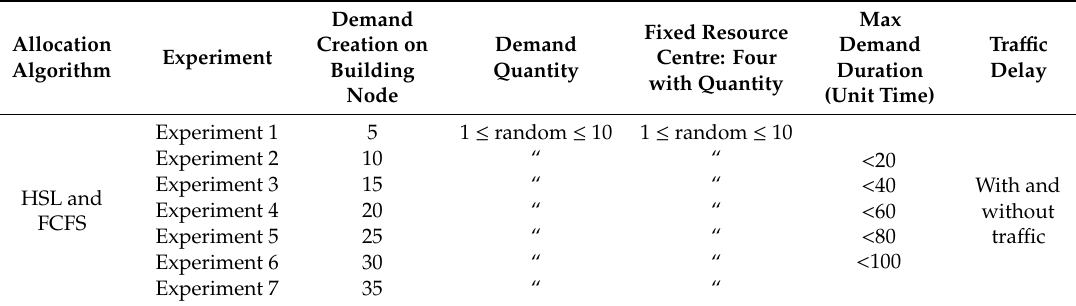
Figure 6. RA in the geographic information system (GIS) Space NetLogo implementation.